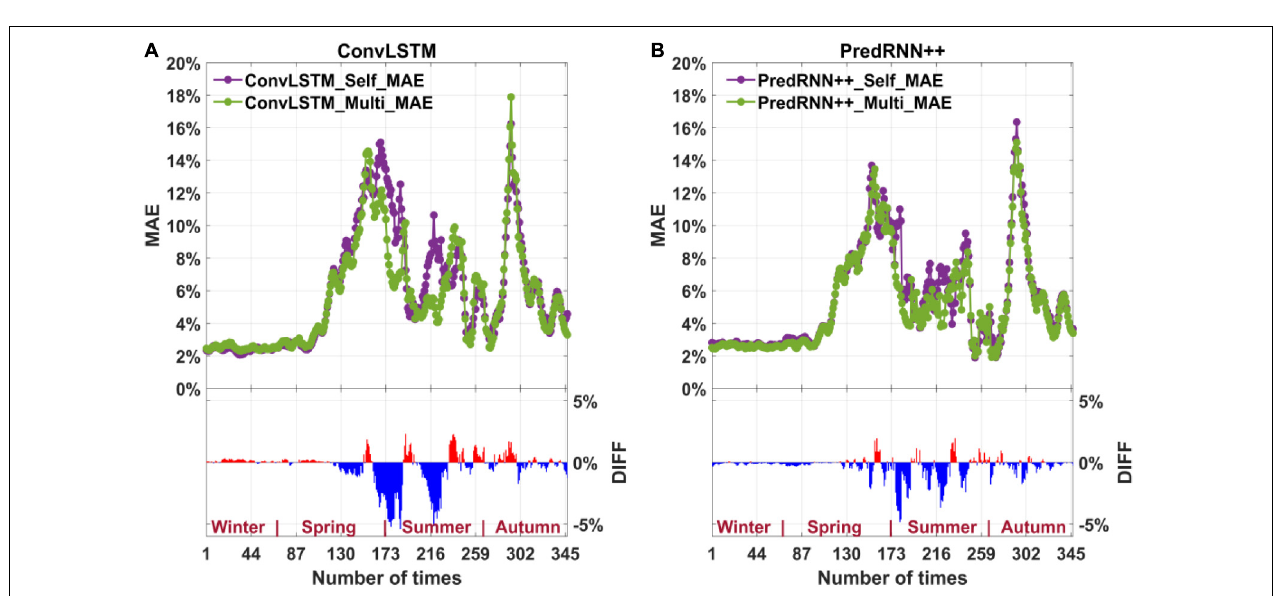
FIGURE 5 | The SSIM for single-factor and multi-factor ConvLSTM predictions based on MAE-loss (A) and the SSIM for single-factor and multi-factor PredRNN++ predictions (B) . The DIFF in the bar graph is obtained by subtracting the single-factor model from the multi-factor model. The red color represents the positive value, and the blue color represents the negative value.